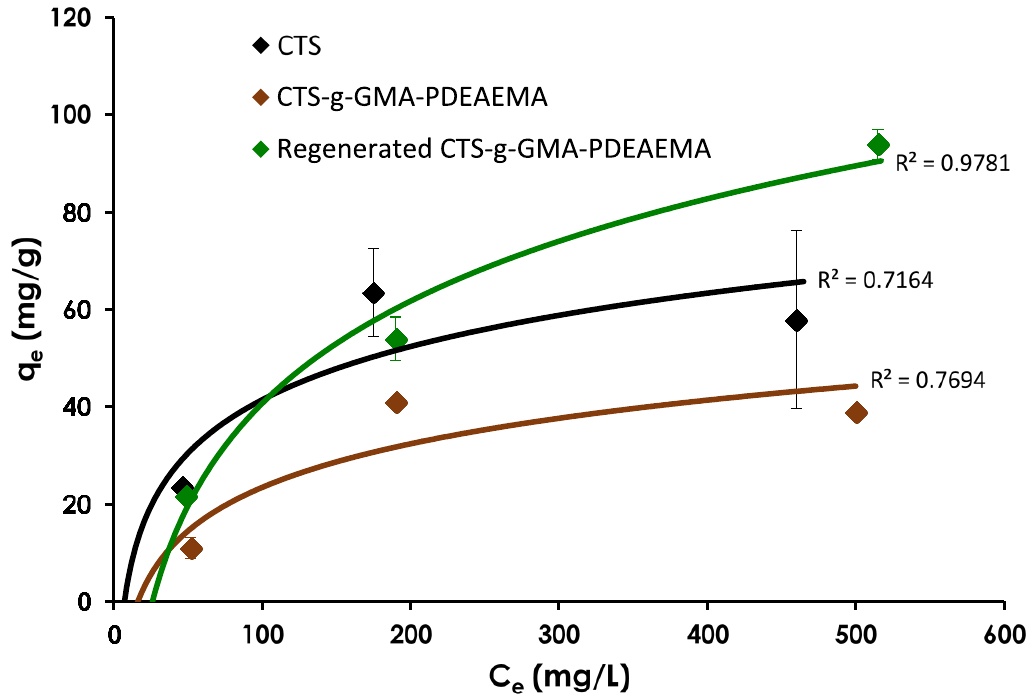
Figure 6. Equilibrium Ni(II) adsorption capacity for chitosan, pure and regenerated CTS– g –GMA–PDEAEMA as a function of equilibrium concentration. Initial pH of adsorption trials was 5.80–5.87 and final was 7.40–7.81. Addition of spent CTS– g –GMA–PDEAEMA to de-ionized water prior to CO 2 sparging yielded a pH of 8.03–8.79. After 1 h of CO 2 sparging the pH decreased to 5.35–5.68.